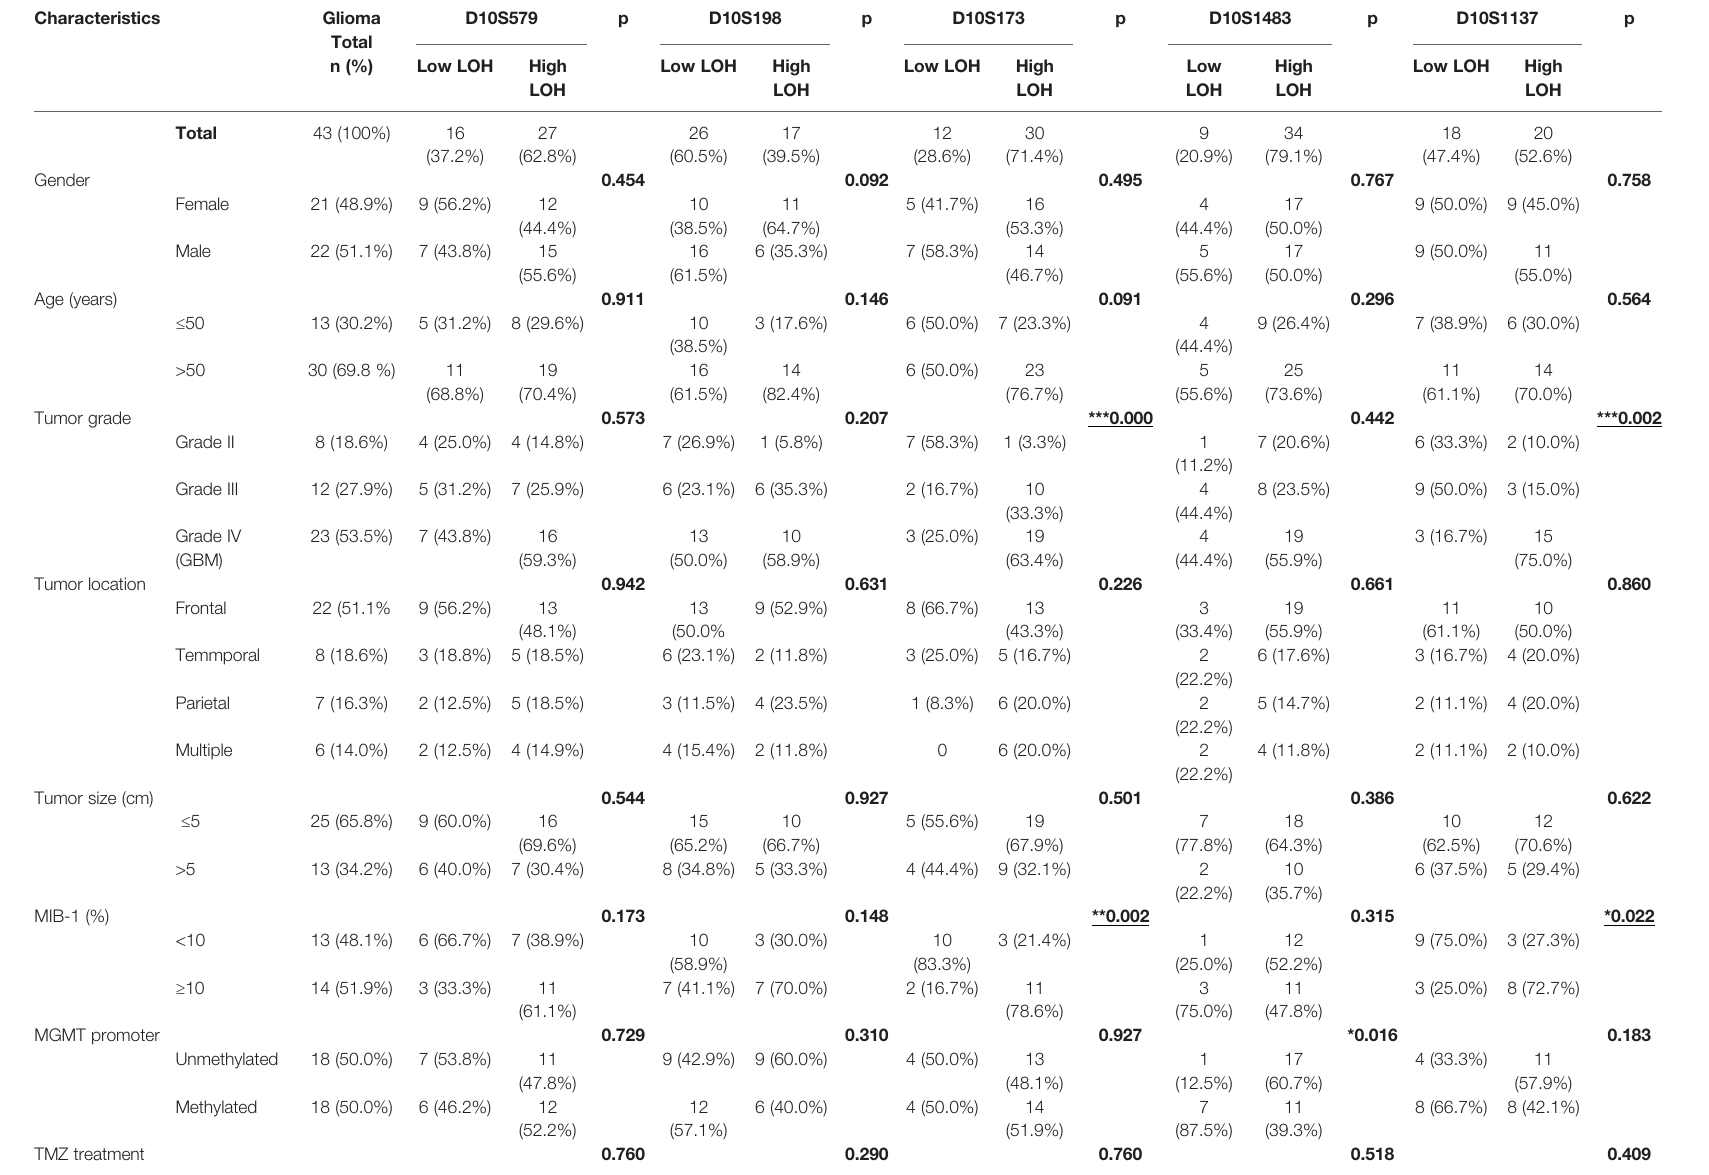
TABLE 1 | Patient demographics and the association between allelic loss at fi ve chromosomal loci on 10q and the clinicopathological features.